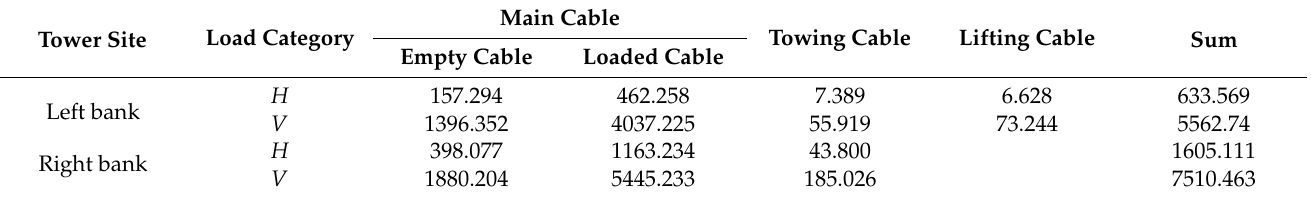
Table 4. The forces acting on the tower tops when the main cable transports a rated load to the middle of the span (unit: kN).